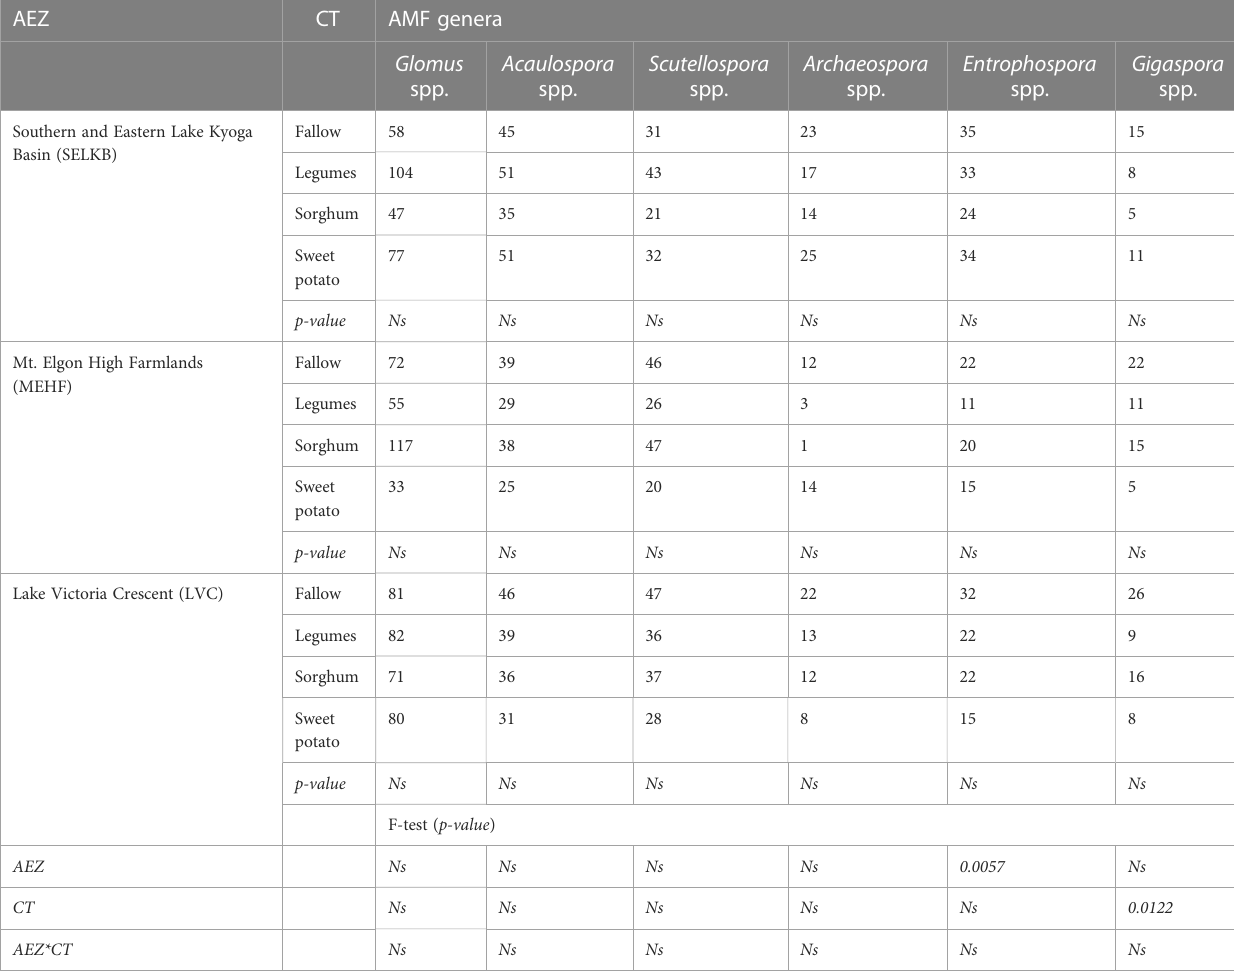
TABLE 3 Mean spore abundance of arbuscular mycorrhizal fungi in 50 g − 1 air-dried soil across AEZs and